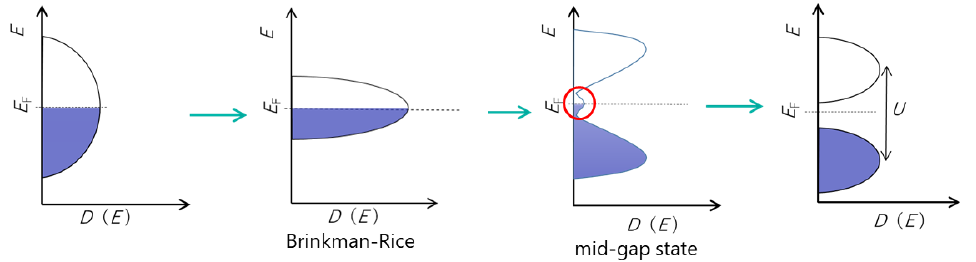
Figure 6. Schematic illustration of the electronic structure expected for the dimer-Mott compounds. Normal band metal on the left side gradually changed to the Mott–Hubbard state with the increase of U / W ratio. The variation from the Brinkman–Rice region to the mid-gap state region may be realized with the increase of partially deuteration.